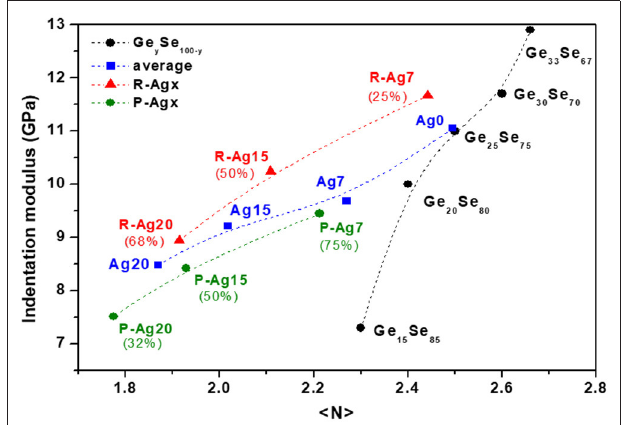
FIGURE 7 | Indentation moduli in function of the mean coordination number for Ge y Se 100 − y glasses (black symbols), Ag x (Ge 0.25 Se 0.75 ) 100 − x glasses (bleu symbols), and R-Agx (red symbols) and P-Agx (green symbols) phases. Percentages correspond to the proportion of R-Agx and P-Agx phase for each composition Agx. The broken lines are drawn as guides for the eye.